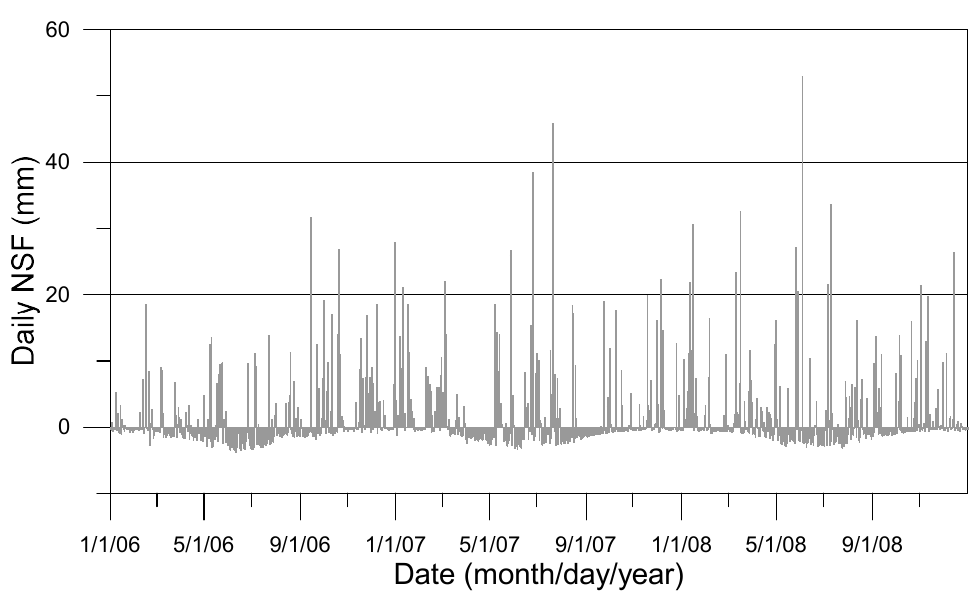
Figure 8. Net surface flux data for Newbury cutting.